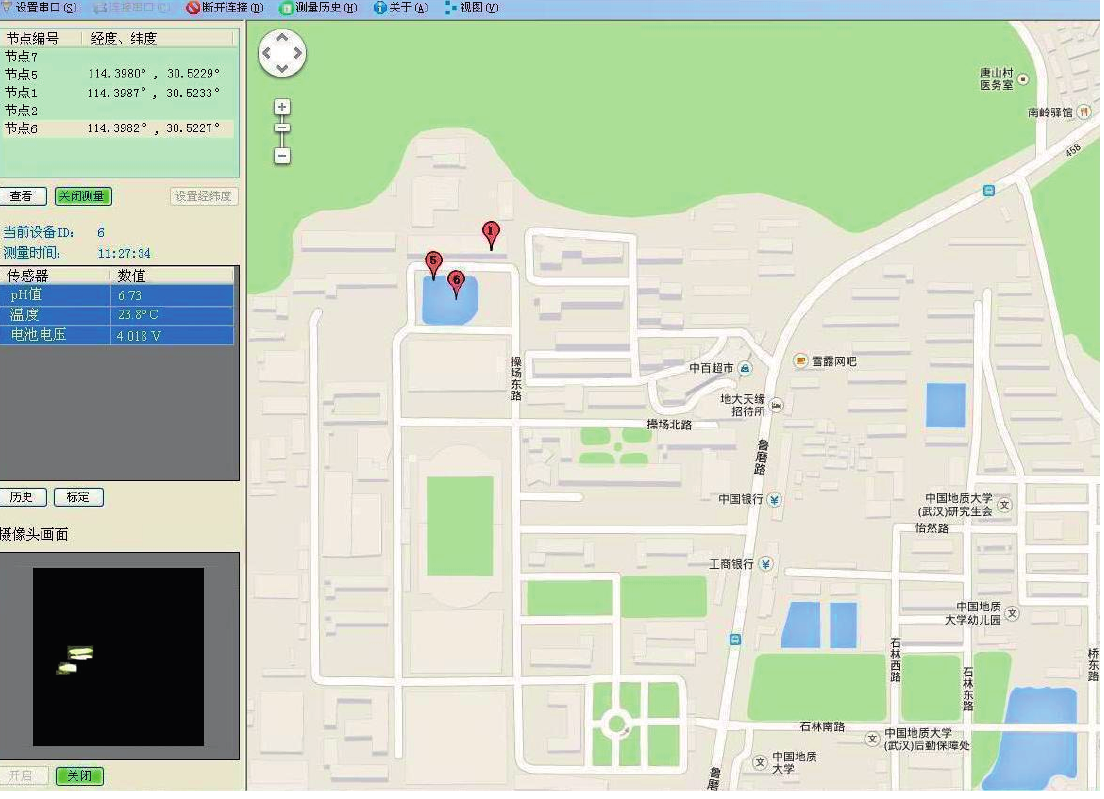
Figure 14. The user terminal screen of the host